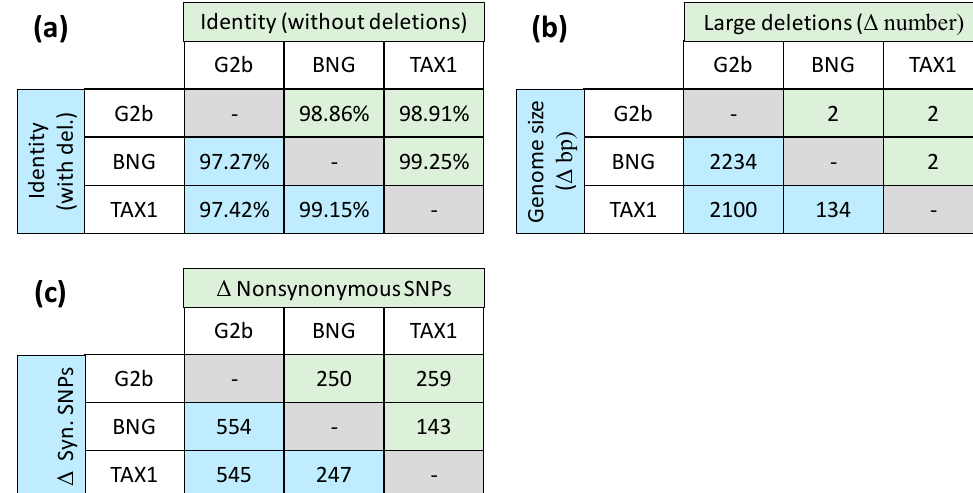
Figure 1. Pairwise comparisons are shown between the three resequencing ‐ derived consensus sequences for SpltNPV ‐ G2b (“G2b”), SpltNPV ‐ Pak ‐ BNG (“BNG”), and SpltNPV ‐ Pak ‐ TAX1 (“TAX1”). The positions above and below the diagonal contain different metrics, and these metrics are indicated to the far left and top of each table. Blue and green shading is used to indicate the pairwise comparison being shown in a panel. ( a ) The percentage shared identity without and with (“with del.”) large deletions included is given. ( b ) The difference in genome size and the difference in the number of large (>100 base pair (bp)) deletions is given. ( c ) The difference in the number of synonymous (syn.) and nonsynonymous single ‐ nucleotide polymorphisms is given. Note that with the exception of the number of large deletions, SpltNPV ‐ Pak ‐ BNG and SpltNPV ‐ Pak ‐ TAX1 are always more similar to each other than to SpltNPV ‐ G2b.